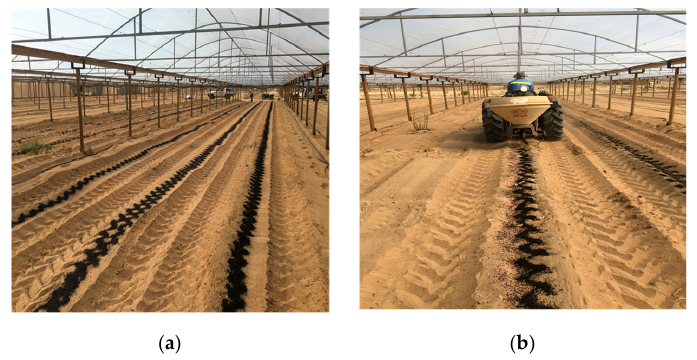
Figure 1. Application of biochar and other amendments ( a ) in rows and ( b ) mini-spreader used. Table 2. Treatment composition applied to the cucumber field.